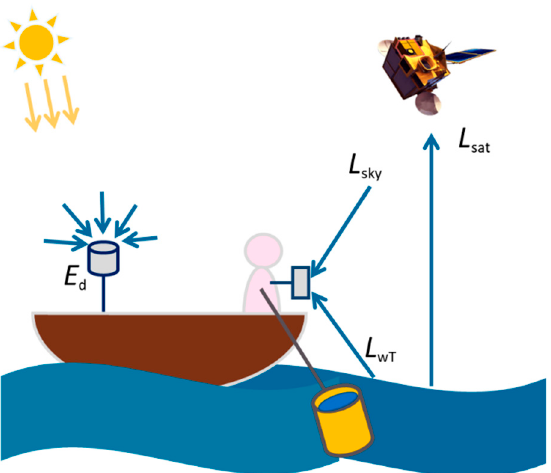
Figure 3. Schematic diagram of on-board measurement procedures for water leaving radiance ( L wT ), sky radiance ( L sky ), irradiance ( E d ), and satellite-observed radiance ( L sat ). Spectral characteristics of seawater can strongly reflect its physical and biological state [41]. Figure 4 shows the bin-averaged distribution of R rs against wavelengths, estimated from in situ spectral measurements for the red tides in 2013 and 2015, turbid waters, and clear sea waters. The bars represent the mean errors of R rs values in each bin of wavelength. For example, clear water (blue lines in Figure 4) shows a decreasing R rs at relatively shorter wavelengths of less than 600 nm and a relatively flat shape at higher wavelengths. Seawater with red tide clearly shows a different spectral shape, which reveals bimodal peaks at 560 and 680 nm (red and magenta lines in Figure 4). By contrast, spectral values corresponding to turbid water (green lines in Figure 4) show high values of about 0.008 sr − 1 near 500–550 nm. All of these measurements were combined to derive a robust algorithm of red tide detection for GOCI